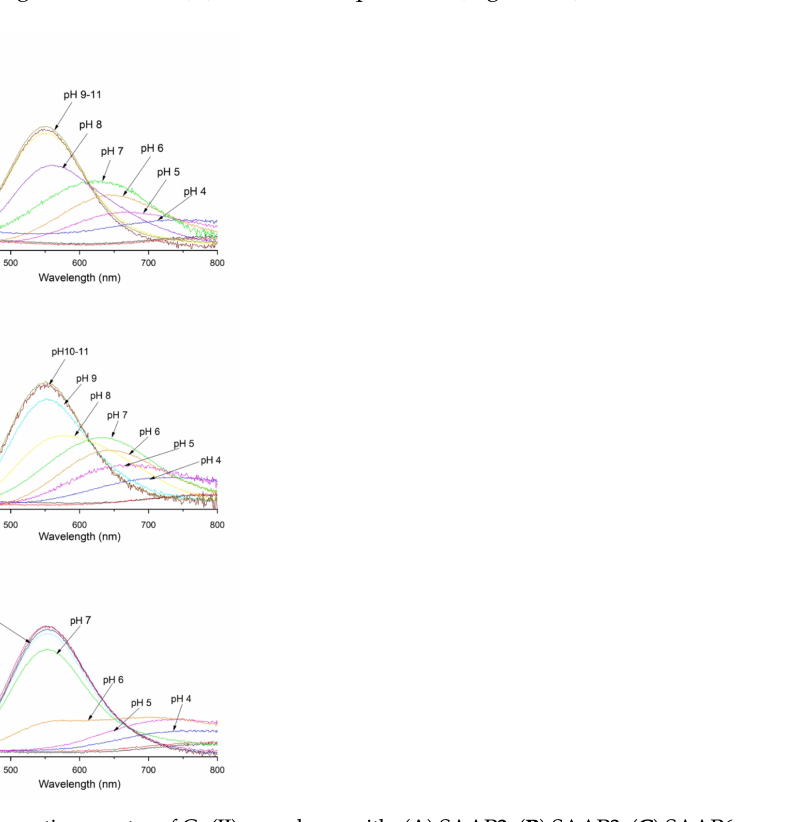
Figure 2. Absorption spectra of Cu(II) complexes with: ( A ) SAAP2; ( B ) SAAP3; ( C ) SAAP6; over the pH range 2–11. Conditions: T = 298 K, 0.1 M NaClO 4 , [Cu(II)] = [SAAP2] = [SAAP3] = [SAAP6] = 1.0